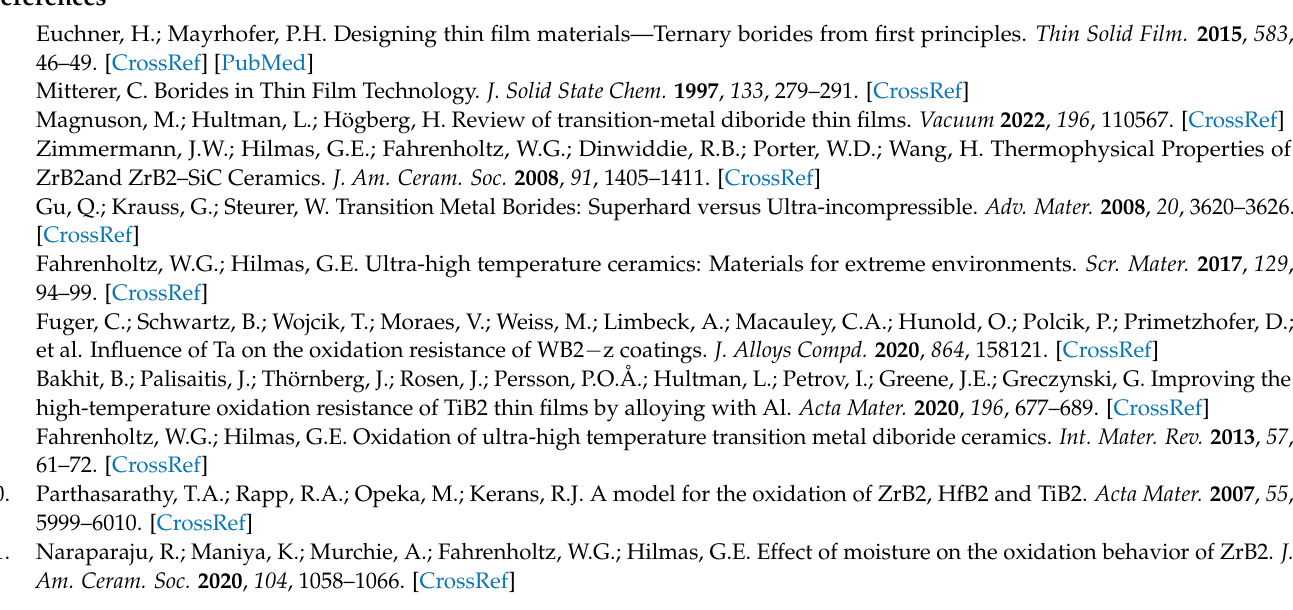
Table S1: ICP-OES parameters for liquid reference